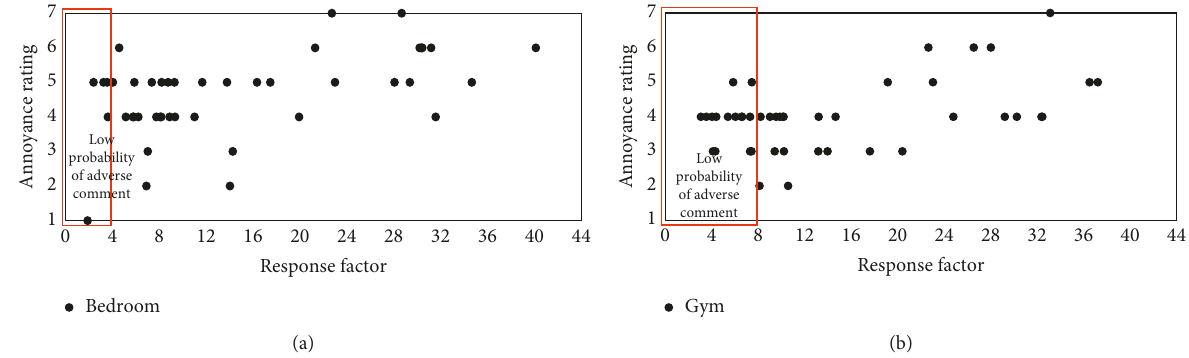
Figure 6: Relationship between the annoyance rating and the response factor of (a) the bedroom and (b) the rest area in a gym.